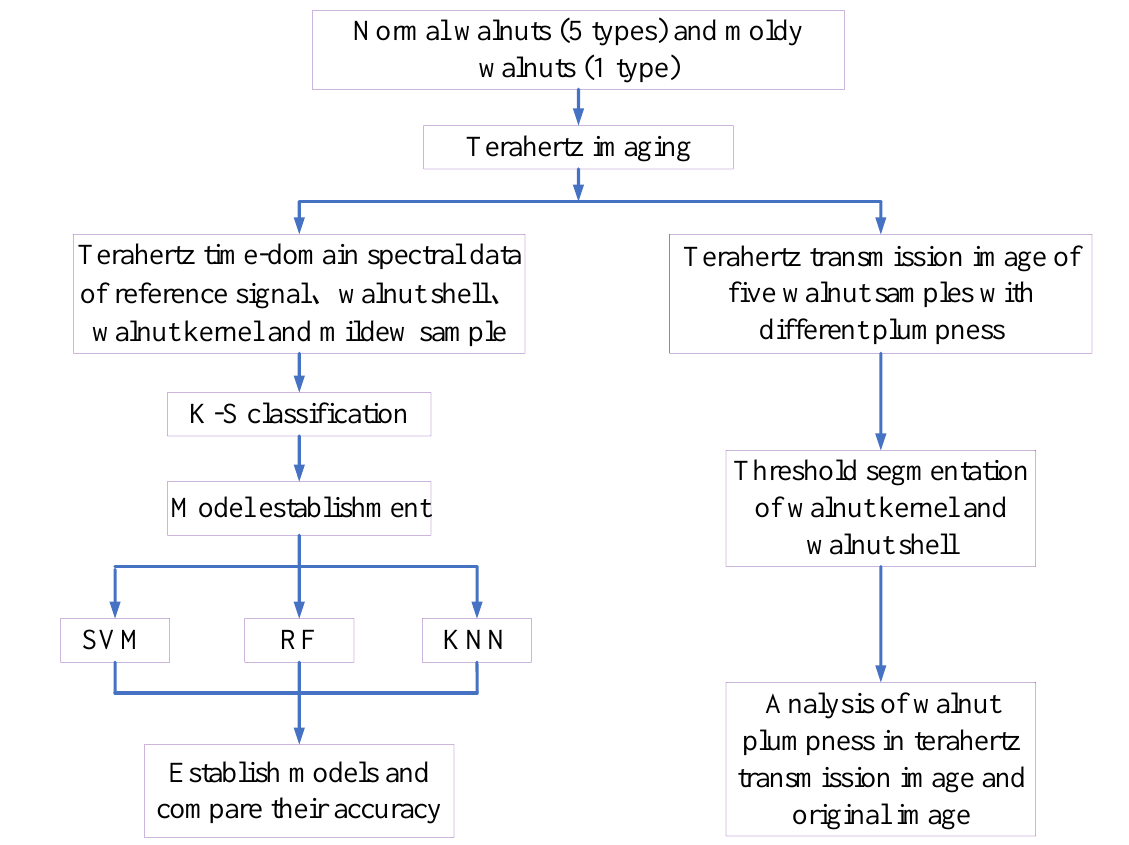
Figure 3. Processing flow for visual analysis of moldy walnuts and fullness.